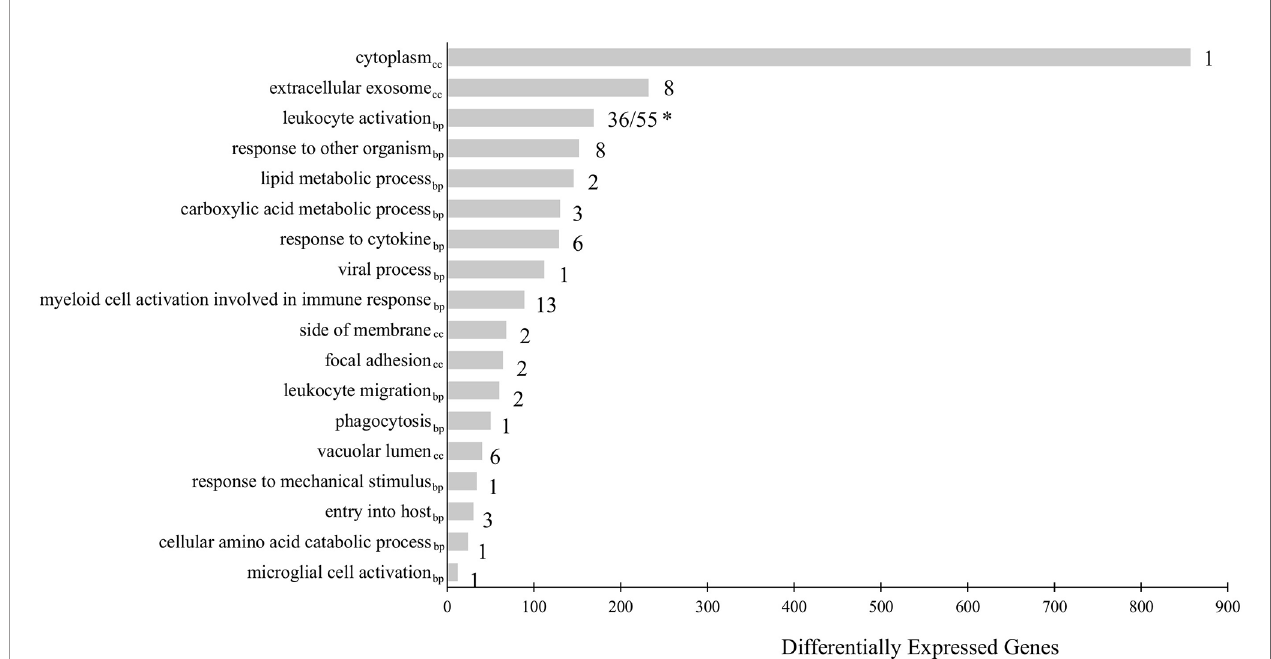
FIGURE 2 | Gene Ontology (GO) term enrichment analysis of all differentially expressed genes (DEGs) between Day 1 and Day 5 HKLs with a fold-change > |2|. The leading term of each identi fi ed group is shown. The bars represent the number of DEGs associated with the term while the number after each bar represents the number of GO terms associated with that group. * “ Leukocyte activation ” is the leading term for two groups: Group 17 (consisting of 36 GO terms) and Group 18 (consisting of 55 GO terms). GO terms from the Biological Process database are identi fi ed by the subscript “ bp ” , while GO terms from Cellular Component are identi fi ed by “ cc ”